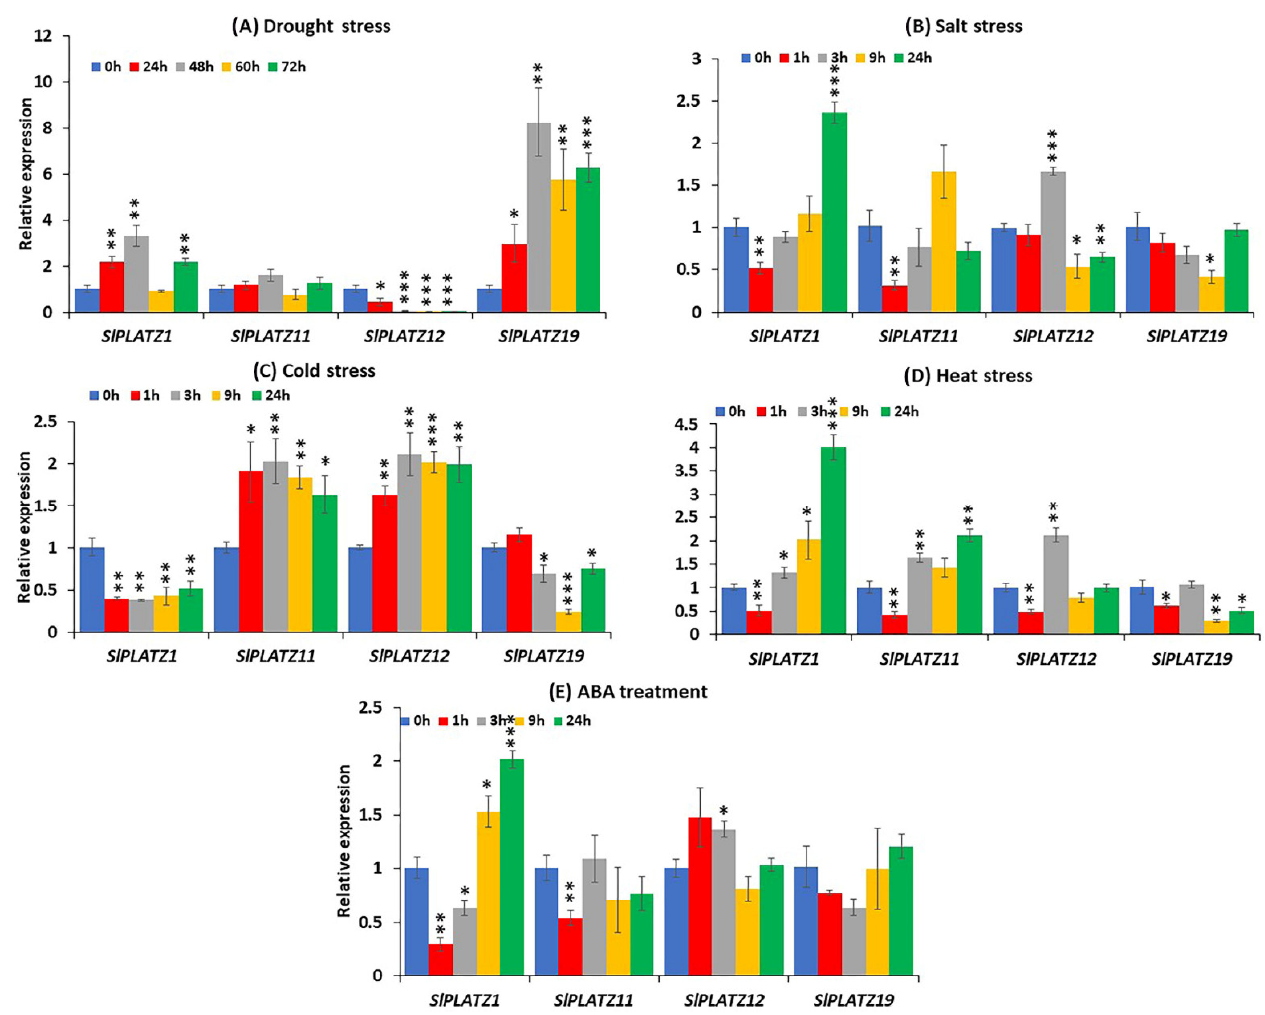
Figure 7. ( A – E ) qRT − PCR analysis of SlPLATZ genes on exposure to different abiotic stresses and ABA treatment. The standard deviations of the average of three biological replicates of the qRT − PCR analysis are represented by error bars. The significant difference between the control samples (0 h) and the stress-treated samples of SlPLATZ genes is indicated by the asterisks (*, **, and ***) determined by Student’s t − test at p − values < 0.05, <0.01, and <0.001, respectively. SlPLATZ1 , SlPLATZ12 , and SlPLATZ19 displayed responses to drought treatment, while the transcript levels of SlPLATZ11 were not significantly altered at all time points of the stress period (Figure 7A). In comparison with the control (0 h), the transcript levels of SlPLATZ1 were significantly induced by >2-fold at 24 h after drought treatment and peaked (>3-fold) at 48 h in response to drought stress. Although the expression of SlPLATZ1 was unchanged at 60 h upon exposure to drought conditions, it was upregulated (>2-fold vs. the control) again at the last stage of the drought period. Similarly, SlPLATZ19 was highly up-regulated (2.9- to 8.2-fold) at all stages of drought treatment relative to the control. By contrast, the mRNA transcript levels of SlPLATZ12 were considerably downregulated (>2- to >55-fold relative to the control) throughout the drought stress